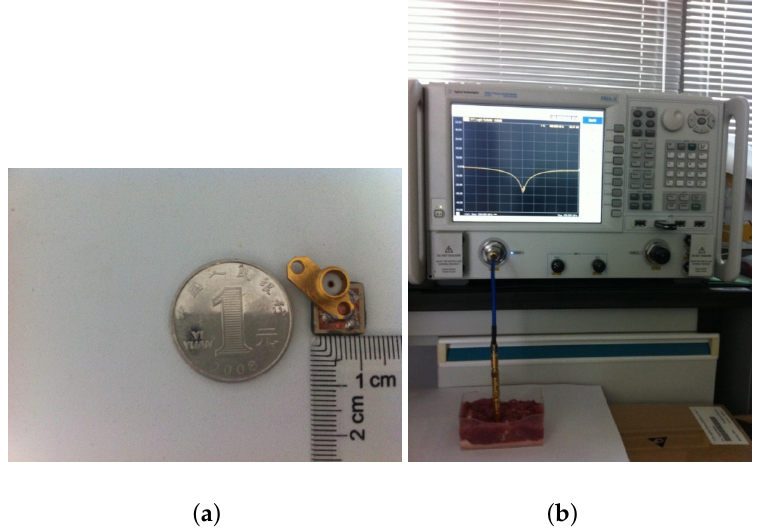
Figure 7. The fabricated prototype and the experimental setup of the proposed antenna. ( a ) The actual fabricated antenna; ( b ) in vitro experiment setup with pork shoulder.